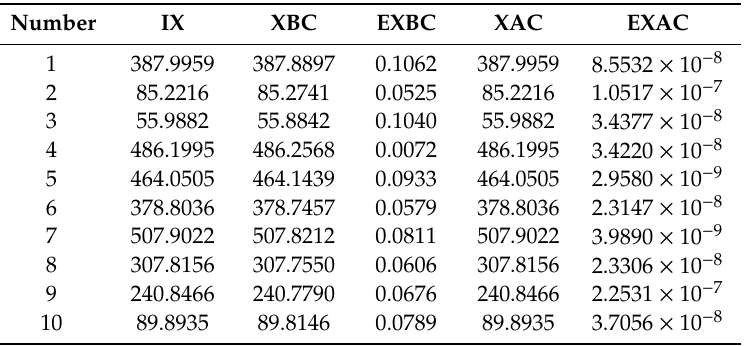
Table 3. The systematic error before and after compensation of the simulated star image with σ PSF =